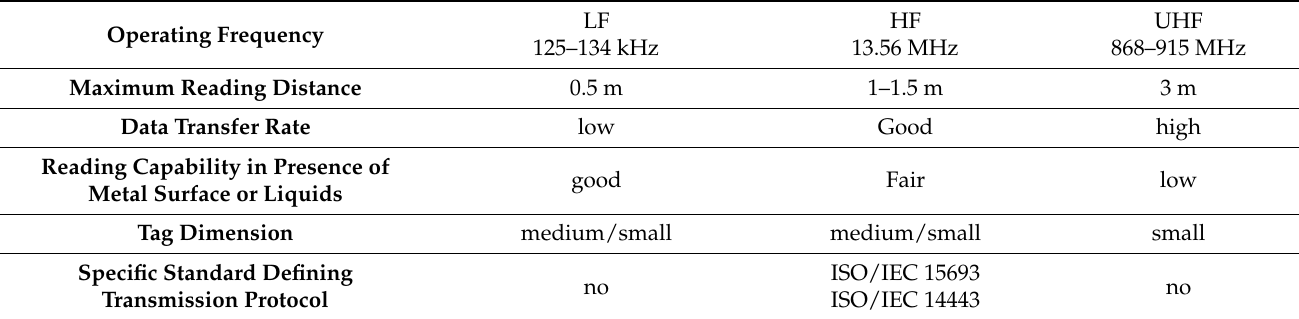
Table 1. Main characteristic of RFID technology in the bands LF, HF and